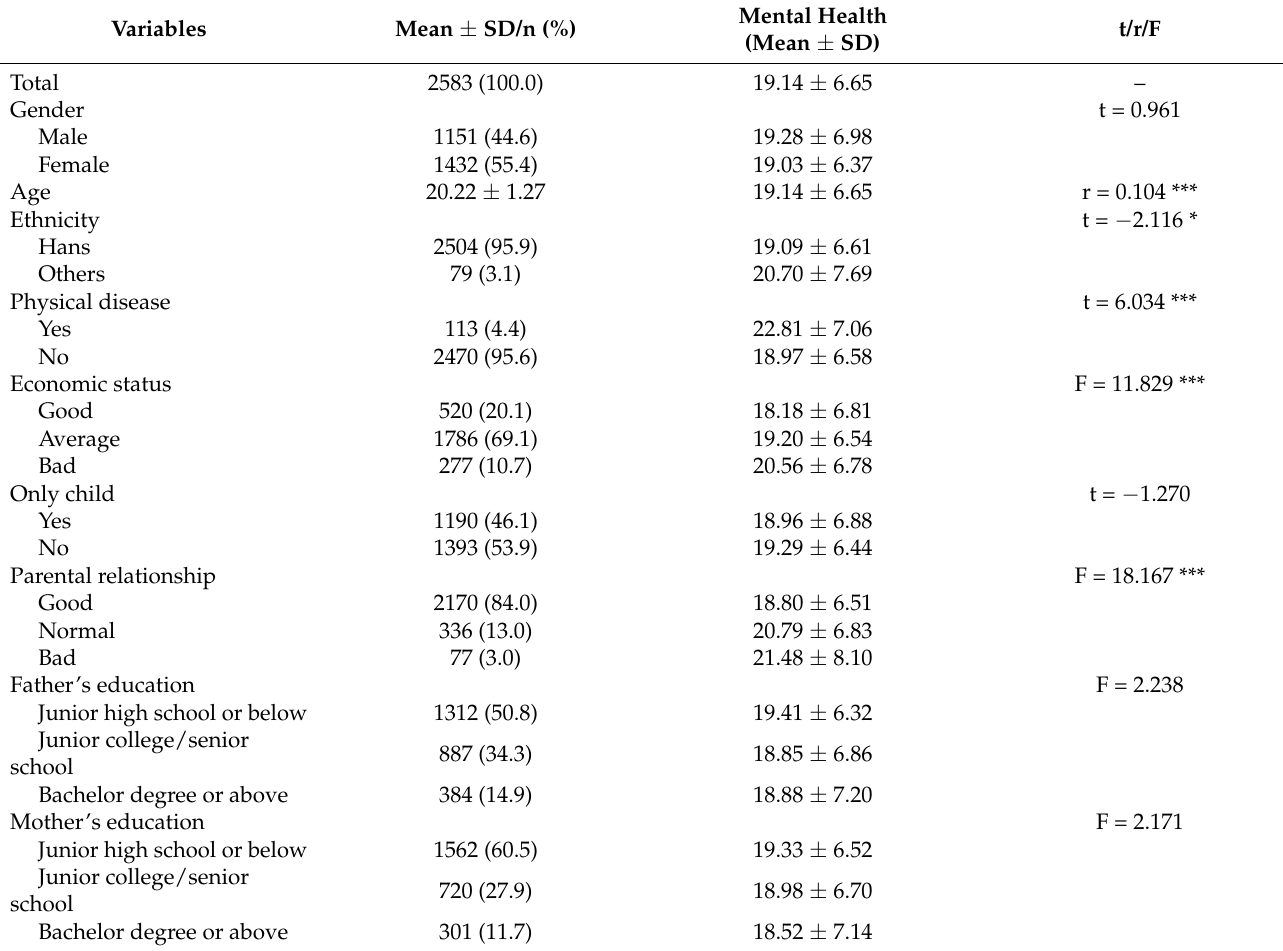
Table 1. Sample description and single analyses for the factors associated with mental